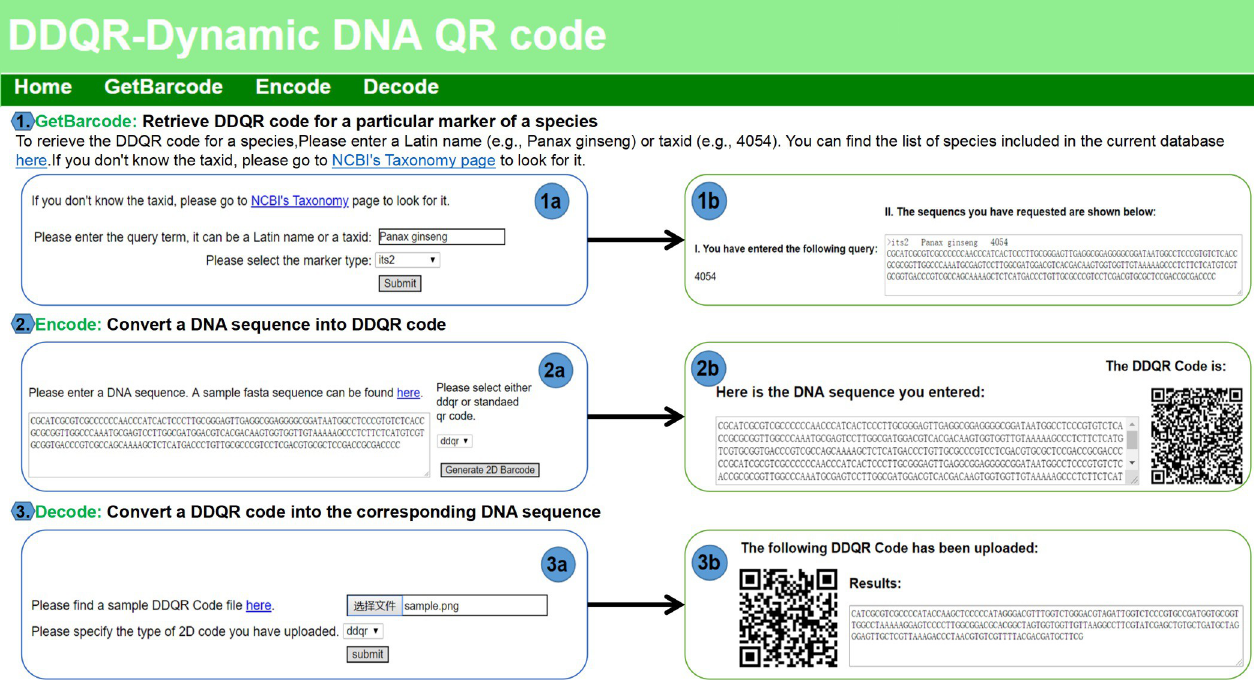
Fig 6. Screenshots of DDQR web server. The module numbers are shaded in blue hexagons. The module names are shown in Green. Various components on the front page, final result page, and intermediate result pages are shaded in blue circles. (1) Module "GetBarcode"; (1a) Front page for "Retrieve DDQR code for a particular marker of a species"; (1b) Results page of the module; (2) Module "Encode"; (2a) Front page for "Convert a DNA sequence into DDQR code"; (2b) Result page showing the generated 2D barcode. (3) Module "Decode"; (3a) Front page for the "Decode a DDQR code into a sequence" module; (3b) Result page showing the original DNA sequence decoded from an input DDQR